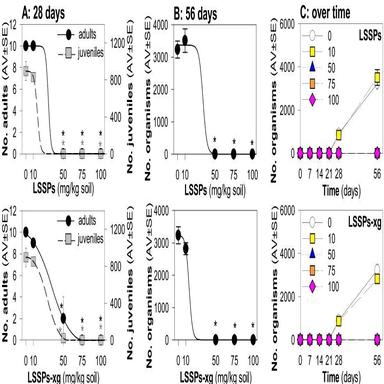
Results in terms of survival and reproduction when exposing Enchytraeus crypticus in LUFA 2.2 soil to LSSPs (Lipid Surfactant Submicron Particles) and LSSPsxg (LSSPs without stabilizer xanthan gum) during (A) 28 days (OECD Standard), (B) 56 days (OECD standard extension), and (C) overview of the time series sampling at days: 7, 14, 21, 28 and 56 days. Values represent number of adults, juveniles, and population as average ± standard error (AV ± SE). \: p < 0.05 (Dunnett's).